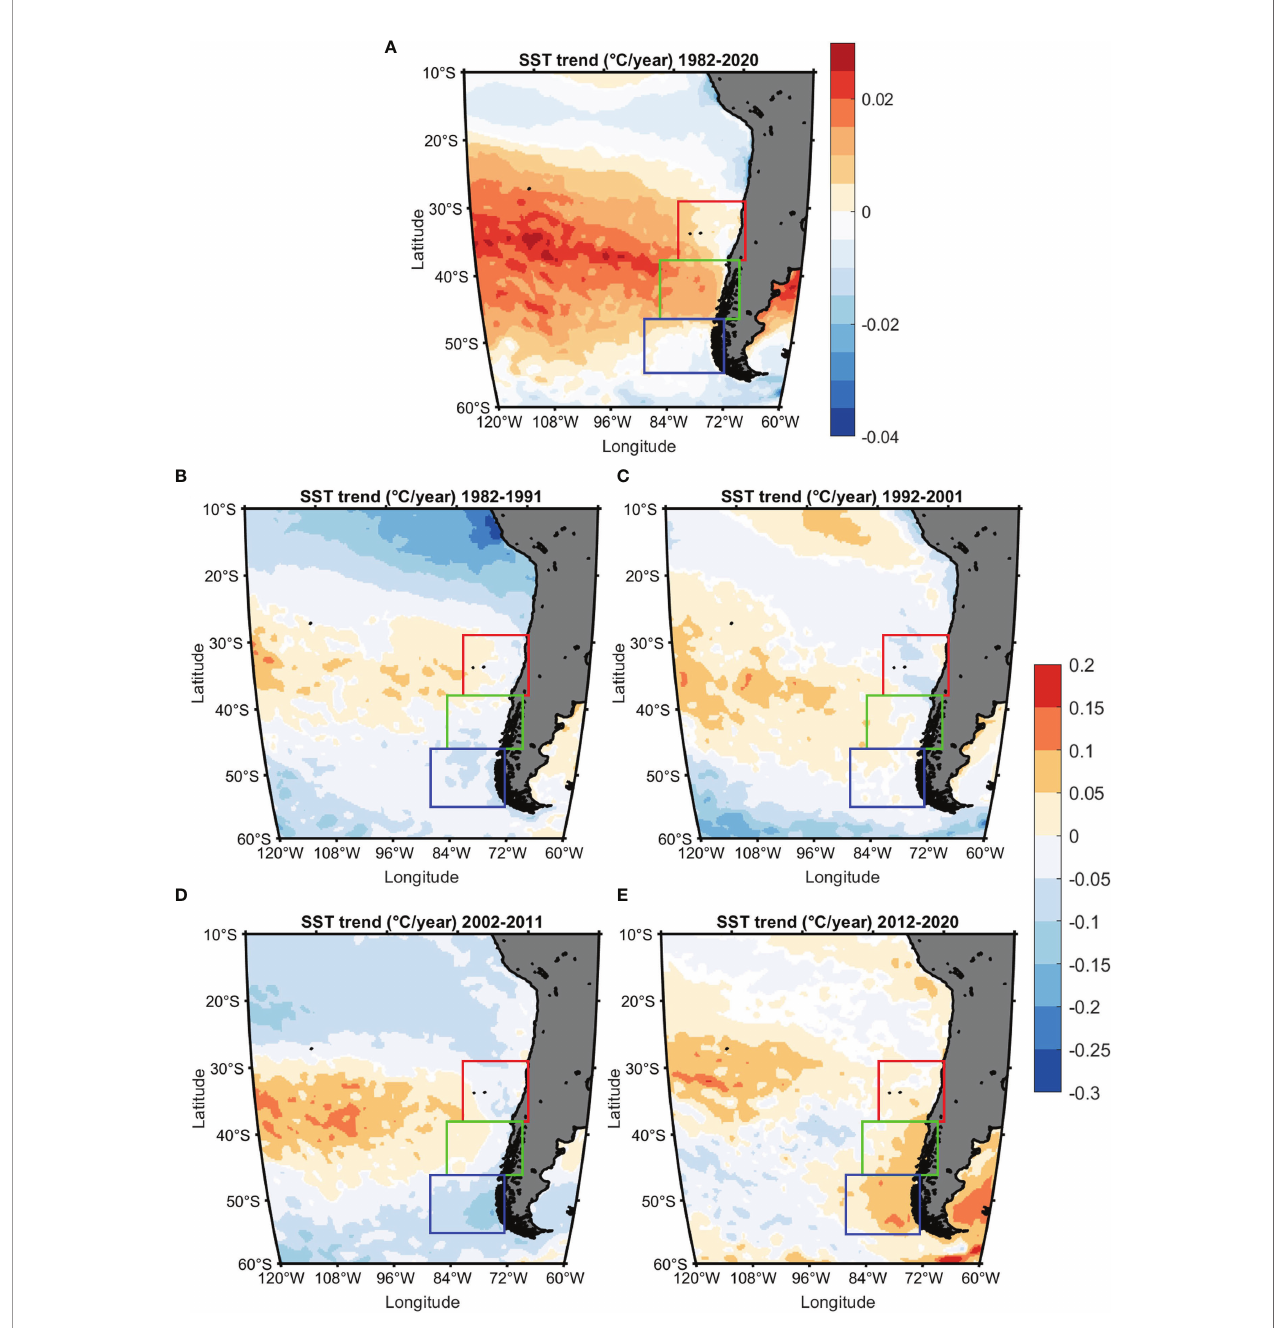
FIGURE 10 | Signi fi cant sea surface temperature (SST) trends (according to pvalue<0.05) in°Cper year for (A) 1982-2020, (B) 1982-1991, (C) 1992-2001, (D) 2002-2011 and (E) 2012-2020. Areas where no signi fi cant trends were observed are